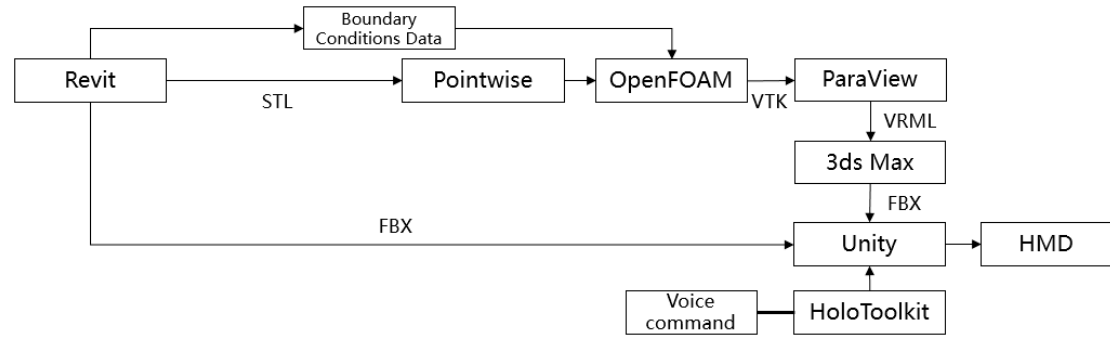
Figure 8. System data flow.